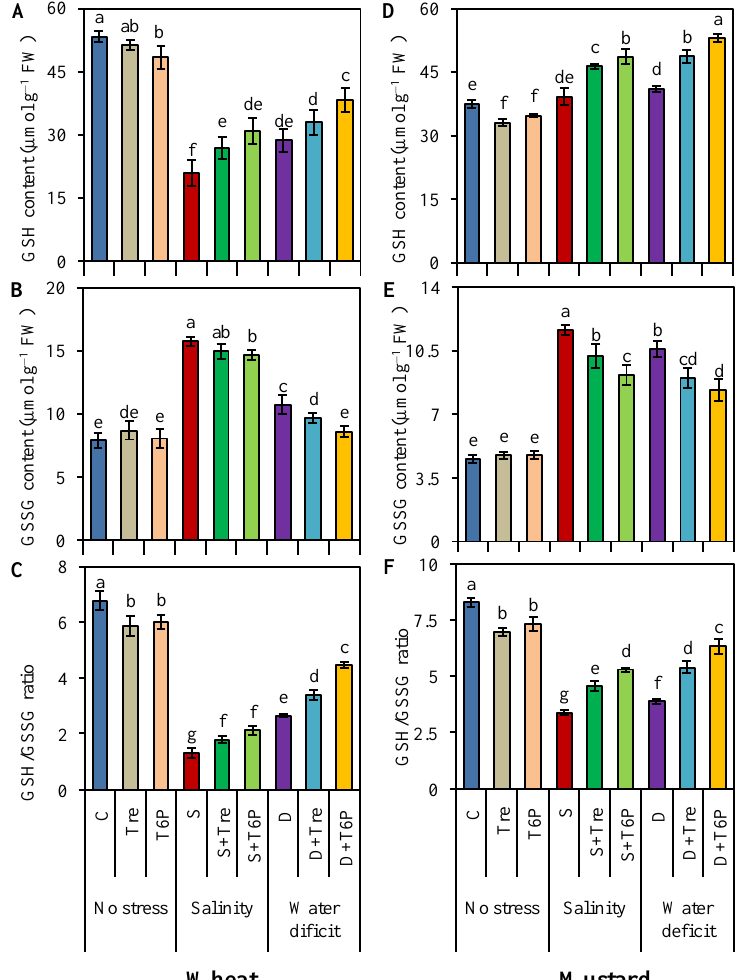
Figure 4. Effect of trehalose and T6P on GSH, GSSG, and GSH/GSSG ratio in wheat and mustard seedlings. Wheat seedlings were grown in a hydroponic solution containing 300 mM NaCl for 9 days. Mustard seedlings were grown in 200 mM NaCl for 10 days. For water deficit treatment, wheat seedlings were treated with 20% PEG, while mustard was treated with 12% PEG for four days. C, control; ( A – C ) wheat; ( D – F ) mustard; Tre, 200 µ M trehalose; T6P, 200 µ M trehalose 6-phosphate; S, NaCl treatment; D, water deficit treatment with PEG 6000. Means were calculated from three replicates for each treatment, and the bars represent the standard deviation ( ± SD). Values with different letters are significantly different at p ≤ 0.05 by Fisher’s LSD